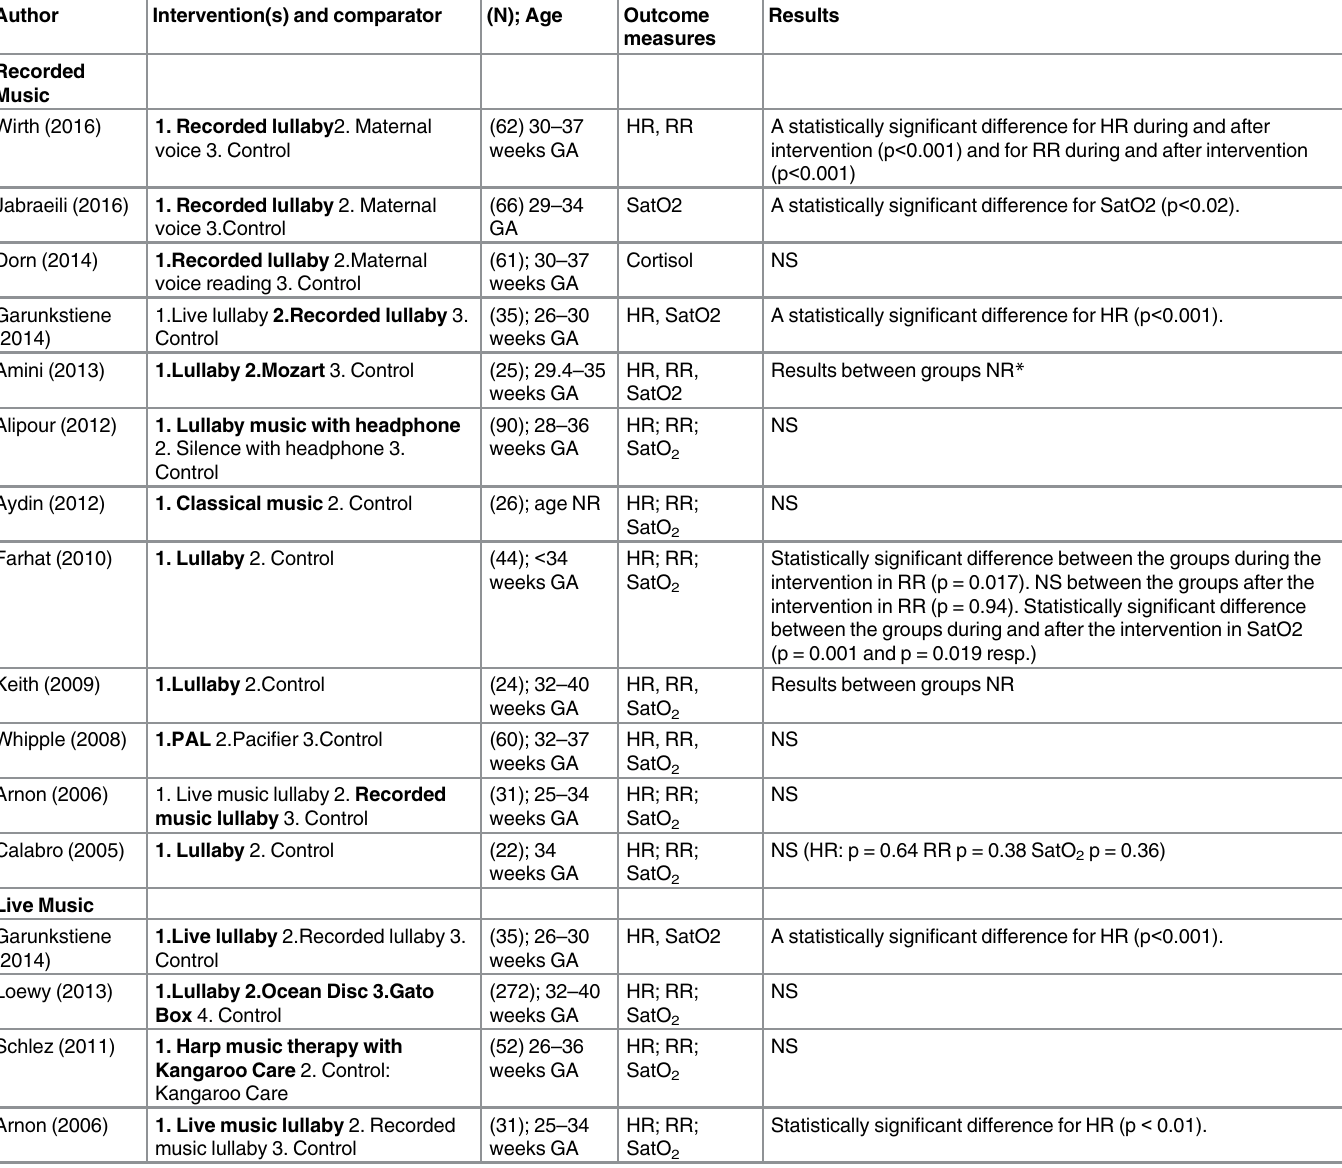
Table 3. Results of the effects of music on physiological parameters . Results of the effects of music on physiological parameters compared between the intervention and control groups. Tabulated results compare the experimental intervention in boldface to the control